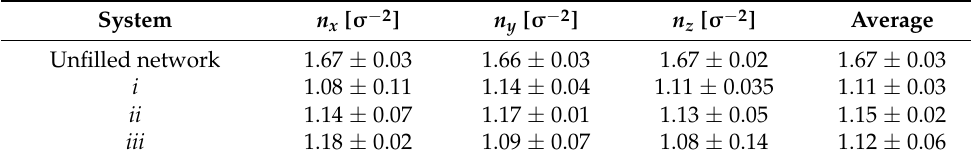
Table 1. The densities of load-bearing chains for the systems with RGC =